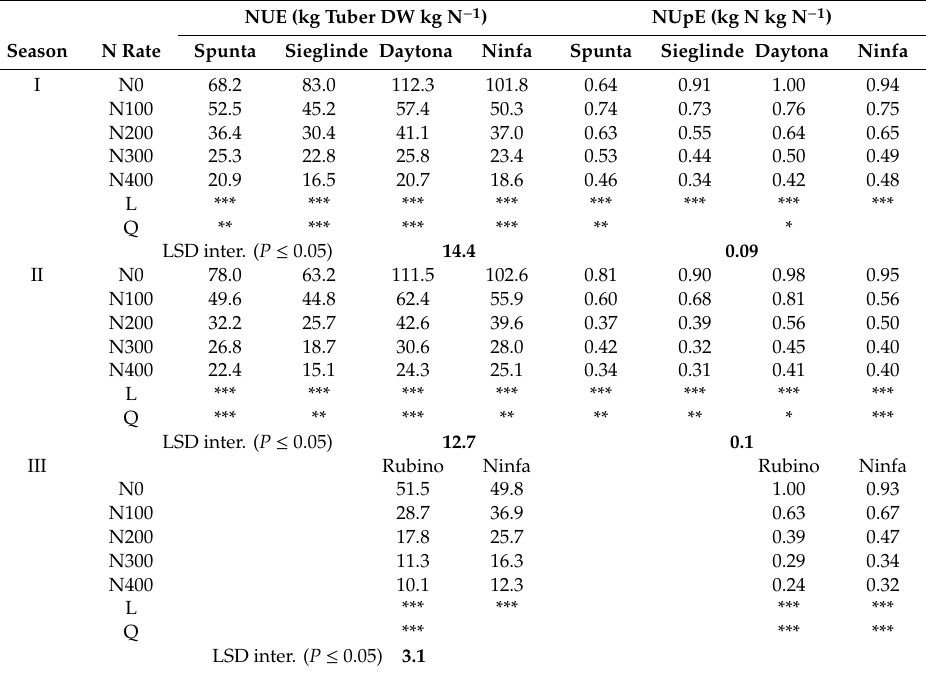
Table 5. NUE (nitrogen use e ffi ciency) and NUpE (nitrogen uptake e ffi ciency) as a ff ected by “nitrogen rate x cultivar” interaction in the three seasons. Relationship tested by regression analysis, between N rate and responses of each variable and cultivar (L = linear, Q = quadratic; *, **, *** indicate significance at P < 0.05; P < 0.01; P < 0.001.